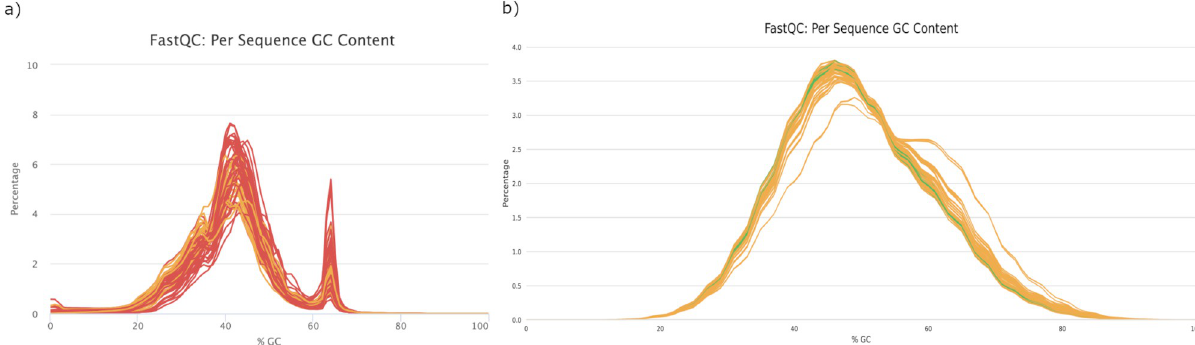
Fig 1. Percentage of reads against GC content. a) 3’ UTR-seq; b)